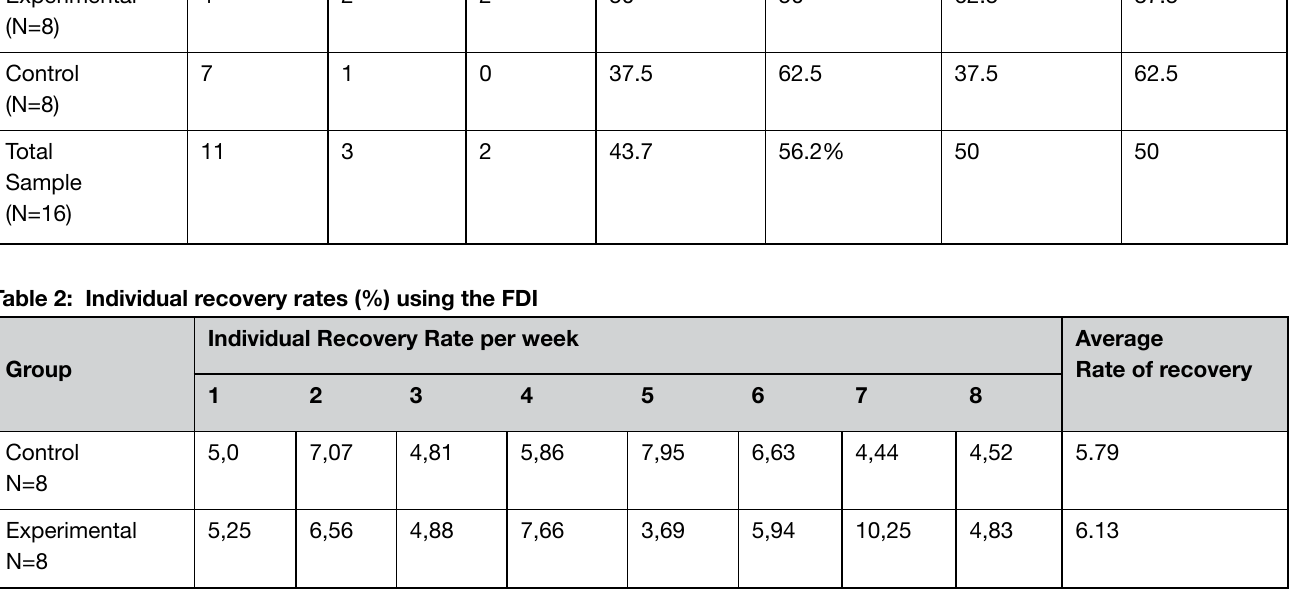
Table 1: Demographics information of participants in the study (n=16) Different Blacks whites Asians groups Experimental